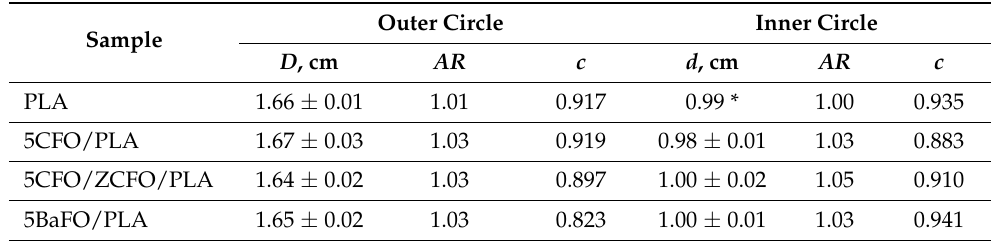
Table 3. Geometrical parameters of printed rings: D and d are the diameters of the outer and inner circles, AR is the aspect ratio, and c is the circularity index. Outer Circle Inner Circle Sample D , cm